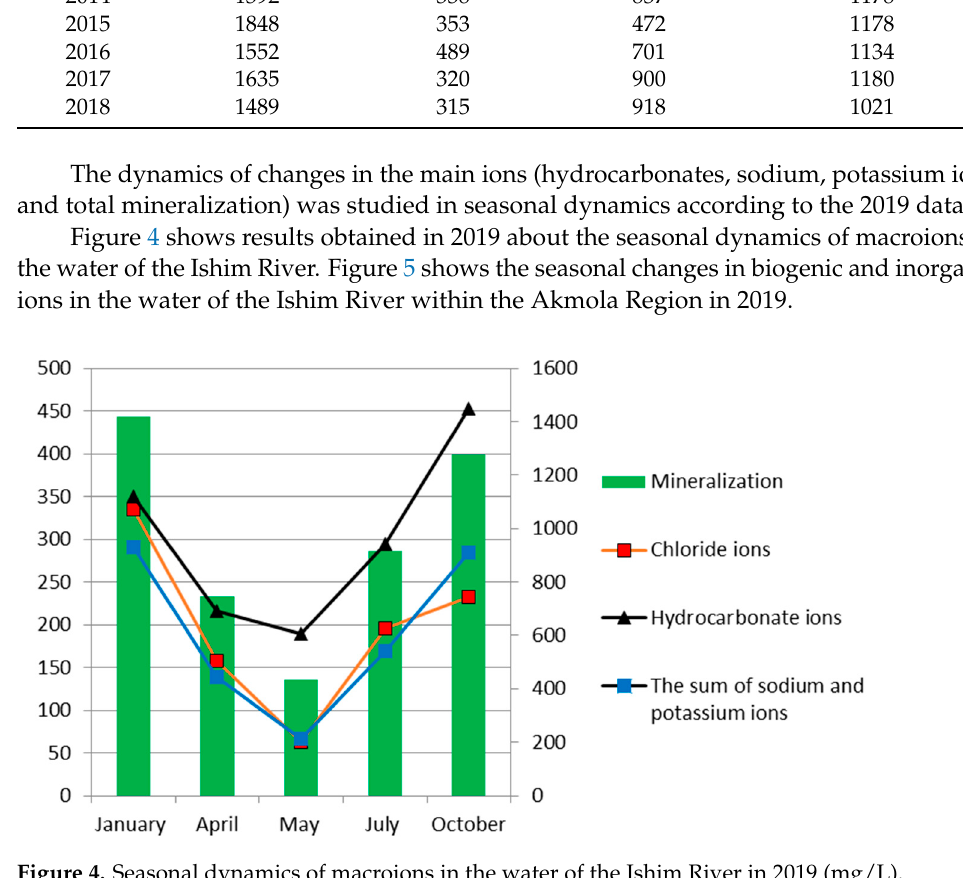
Figure 4. Seasonal dynamics of macroions in the water of the Ishim River in 2019 (mg/L).